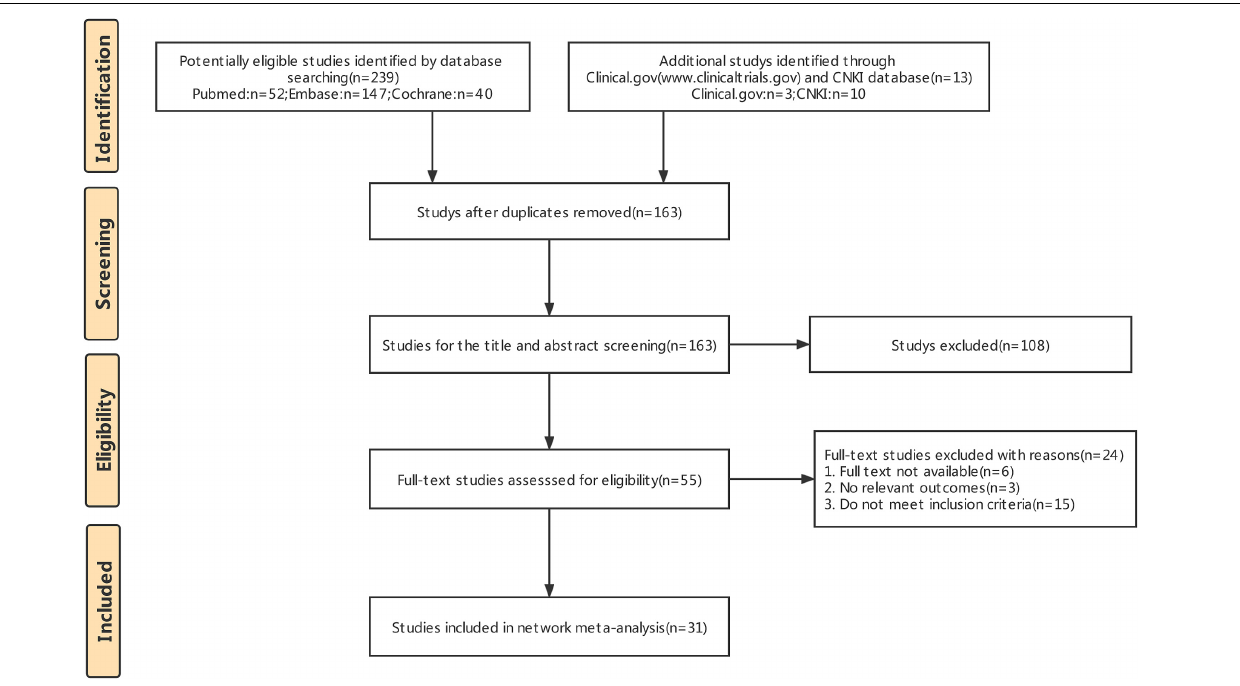
FIGURE 1 | Flow diagram of the literature search and